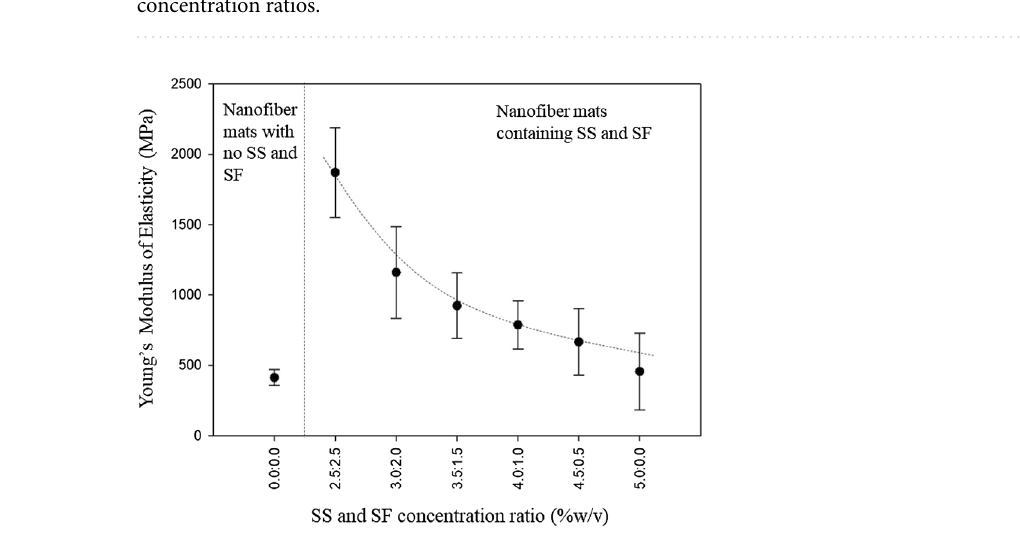
Figure 4. Young’s modulus of elasticity of the fabricated nanofiber mats with different SS/SF concentration